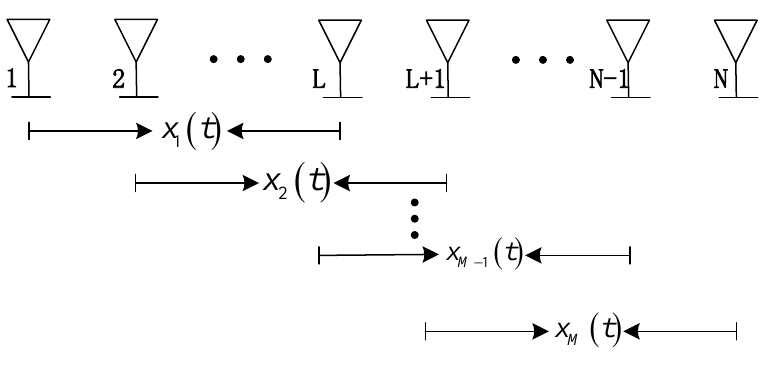
Figure 2. Forward Spatial